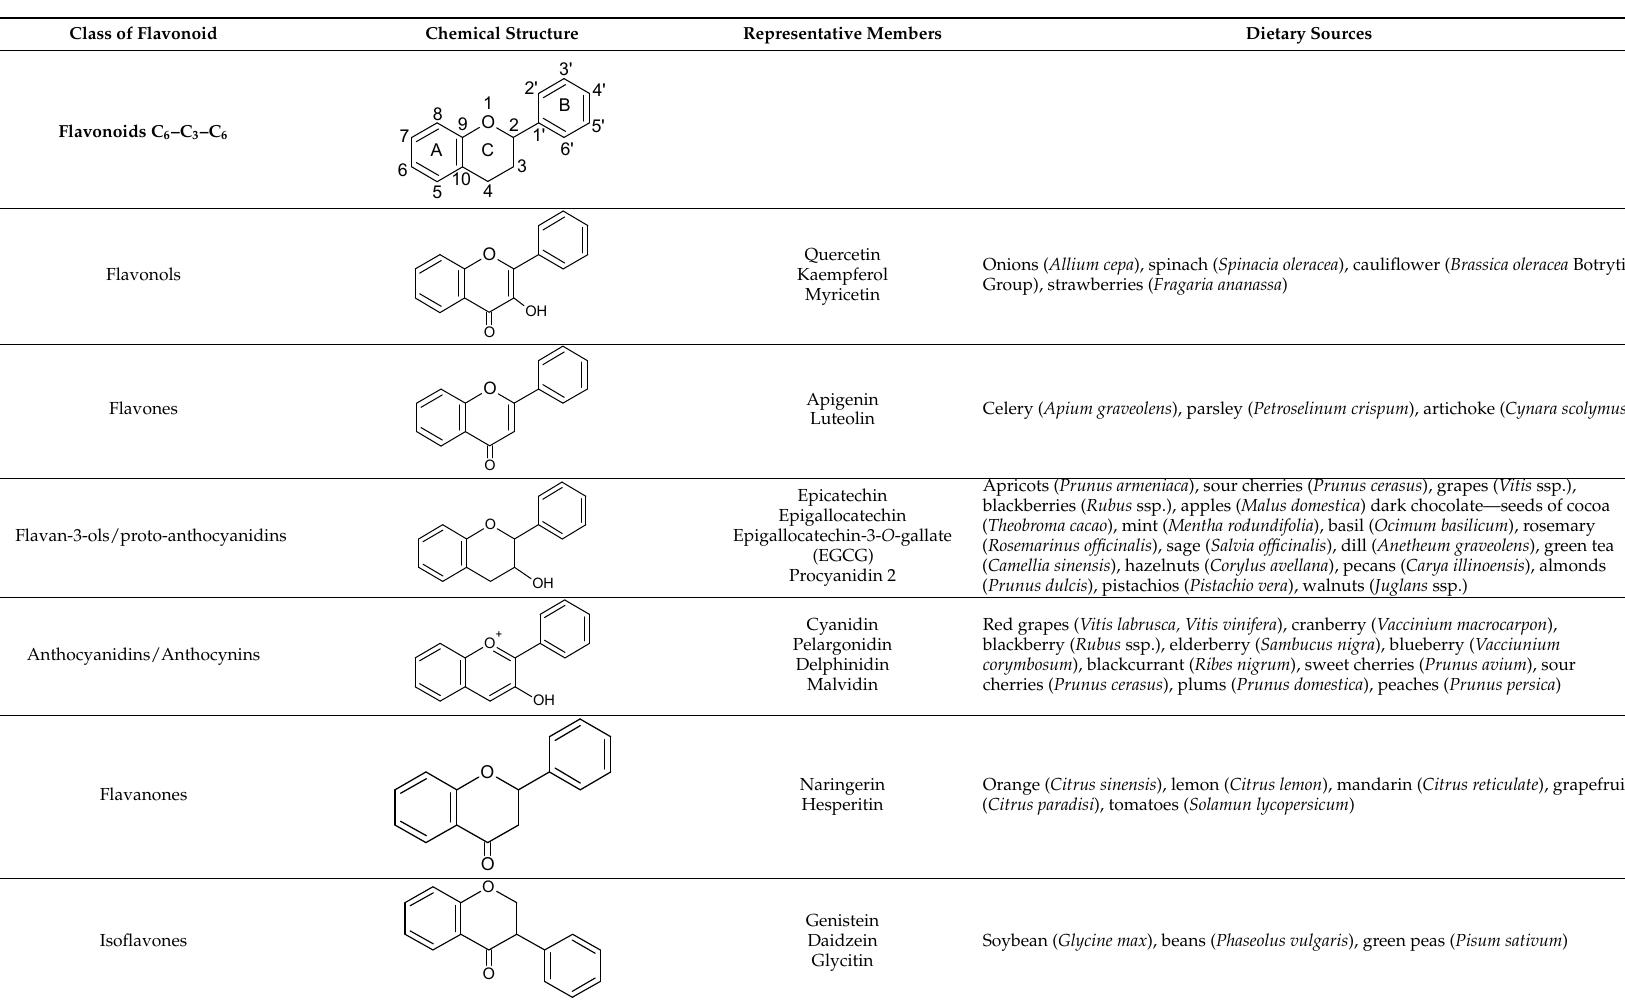
Table 1. Main classes of flavonoids with chemical structure, representative members and dietary sources [36,39,45,46].